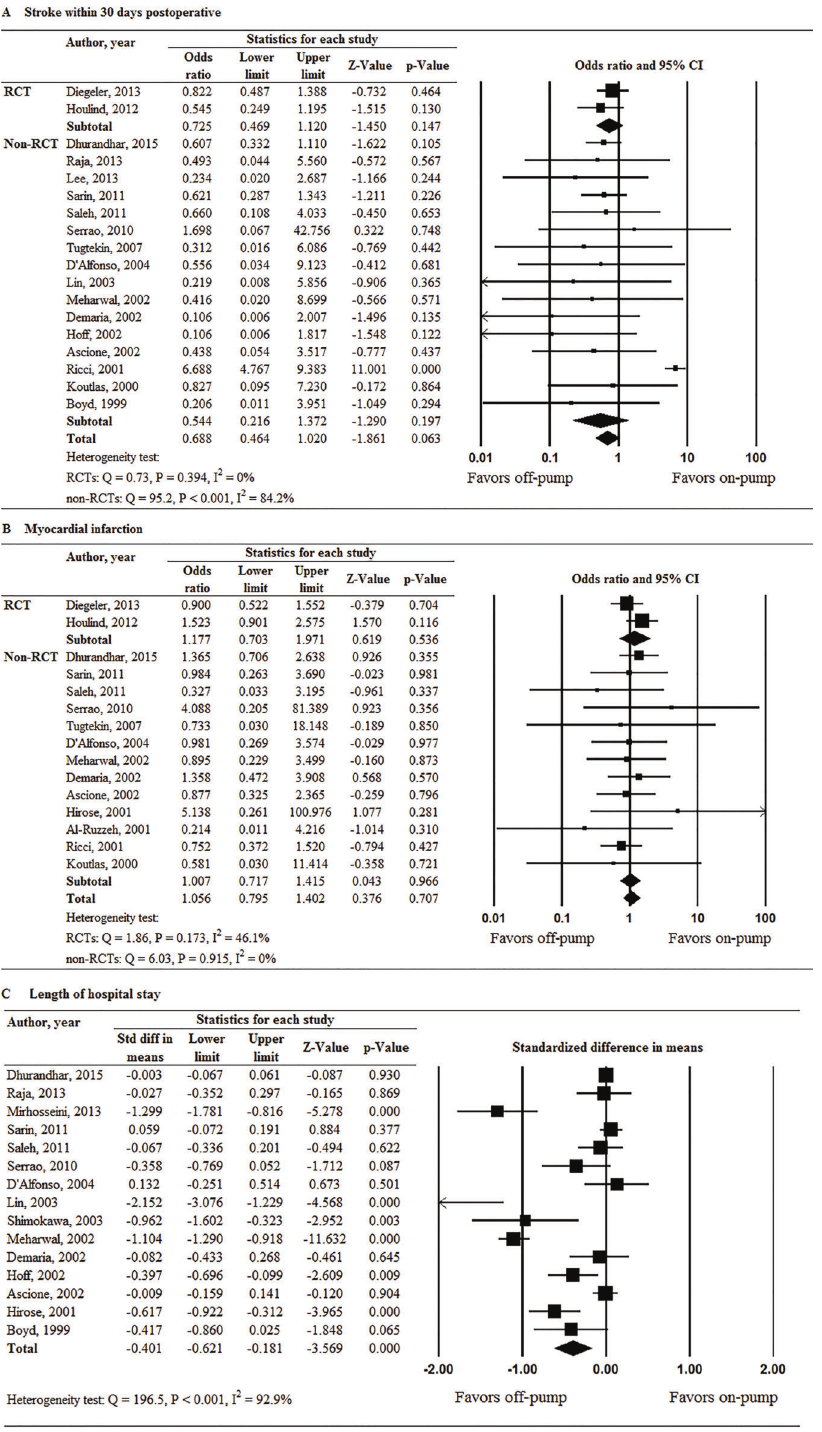
Figure 3. Summary tables and forest plots for treatment effect of off-pump and on-pump coronary artery bypass surgery (CABG) on ( A ) stroke within 30 days postoperative, ( B ) myocardial infarction, and ( C ) length of hospital stay. RCT: randomized clinical